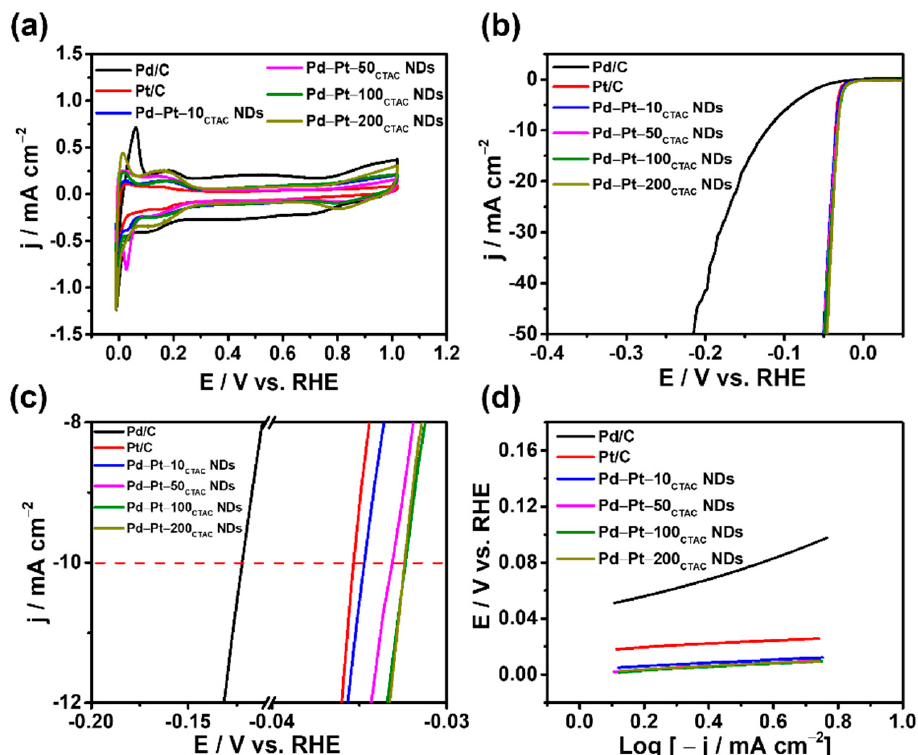
Figure 5. Electrocatalytic HER performance of different Pd–Pt NDs, and commercial Pd/C and Pt/C electrocatalysts measured in 0.5 M H 2 SO 4 saturated with N 2 ; sweep rate at 50 mV s − 1 (CVs) and 10 mV s − 1 (LSV). ( a ) CVs of all Pd–Pt electrocatalysts. ( b ) LSV polarization curves and ( c ) derived from ( b ) to see details of H 2 evolution in overpotential at 10 mA cm − 2 of all electrocatalysts including commercials. ( d ) Corresponding Tafel plots recorded on the electrode by polarization curves at potential 10 mV s − 1 . Table 1. Activity values for all electrocatalysts including commercial Pd/C and Pt/C in HER activity. The values including overpotential at 10 mA cm − 2 and Tafel plots compared in 0.5 M H 2 SO 4 .